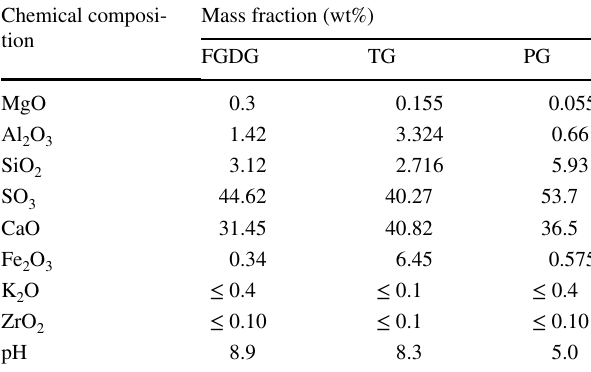
Table 1 Main chemical components of industrial waste gypsum Chemical composi-